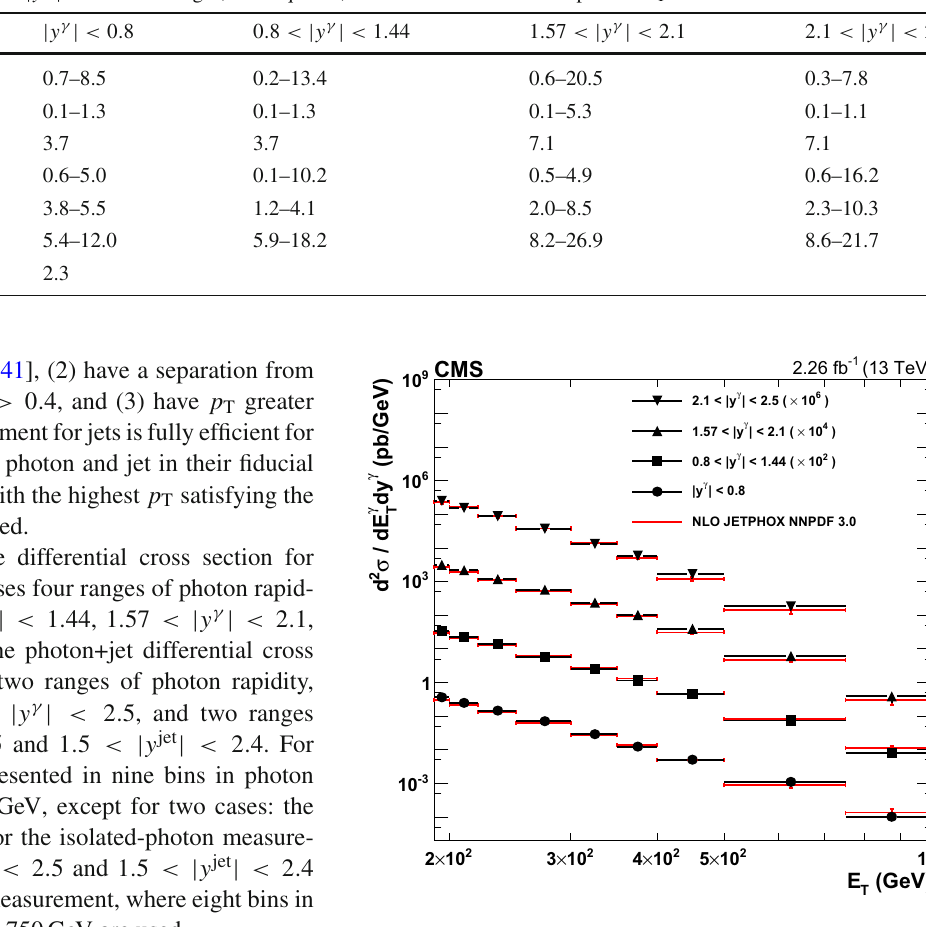
Fig. 3 Differential cross sections for isolated-photon production in photon rapidity bins, | y γ | < 0 . 8, 0 . 8 < | y γ | < 1 . 44, 1 . 57 < | y γ | < 2 . 1, and 2 . 1 < | y γ | < 2 . 5. The points show the measured values and their total uncertainties; the lines show the NLO jetphox predictions with the NNPDF3.0 PDF